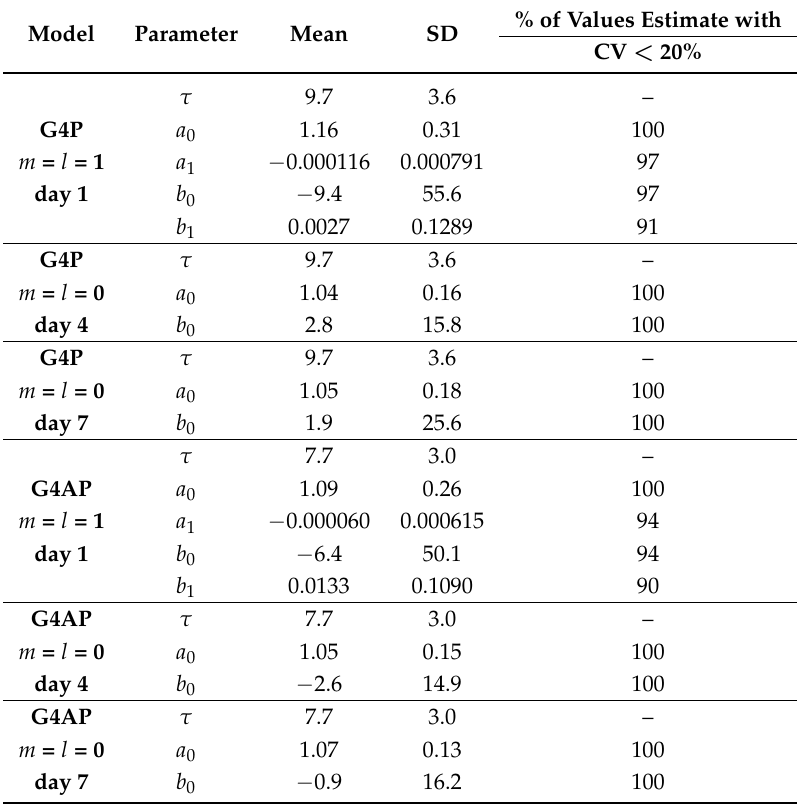
Table 6. Mean and standard deviation values for parameters and percentage of values estimated with a coefficient of variation lower than 20% for the Dexcom G4 PLATINUM (G4P) and advanced G4 for artificial pancreas studies (G4AP)